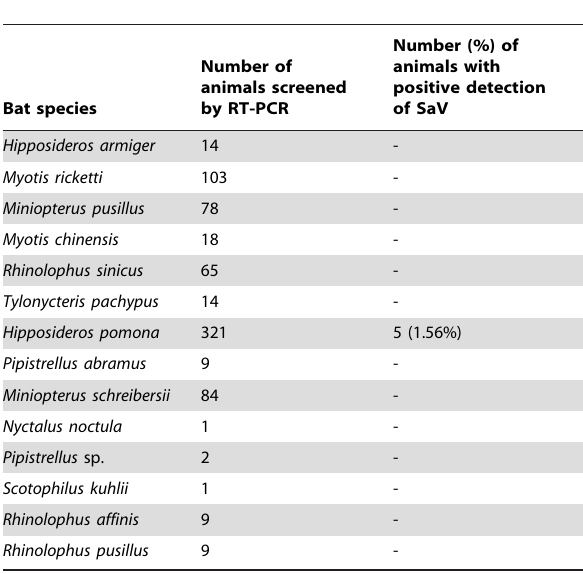
Table 1. Species distribution of specimens and RT-PCR surveillance results in the present